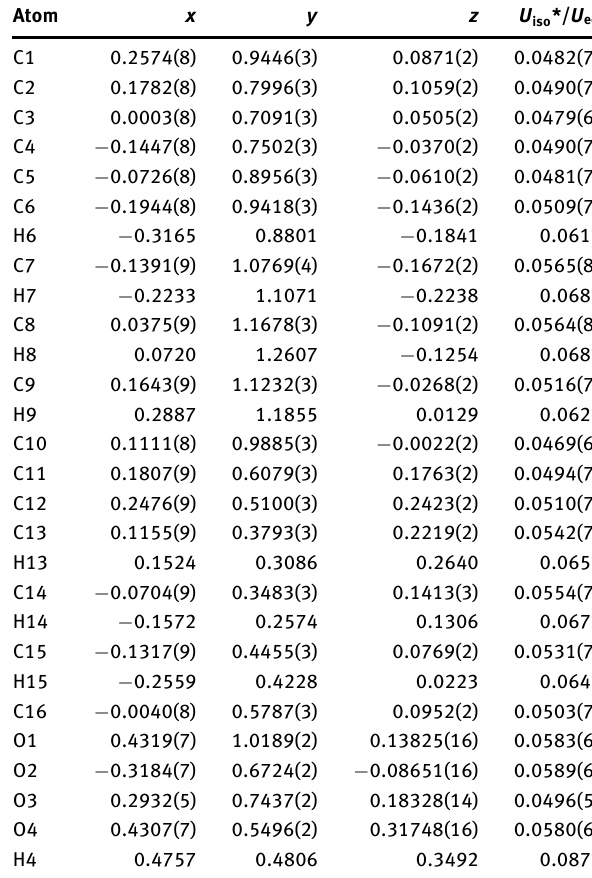
Table 2: Fractional atomic coordinates and isotropic or equivalent isotropic displacement parameters (Å 2